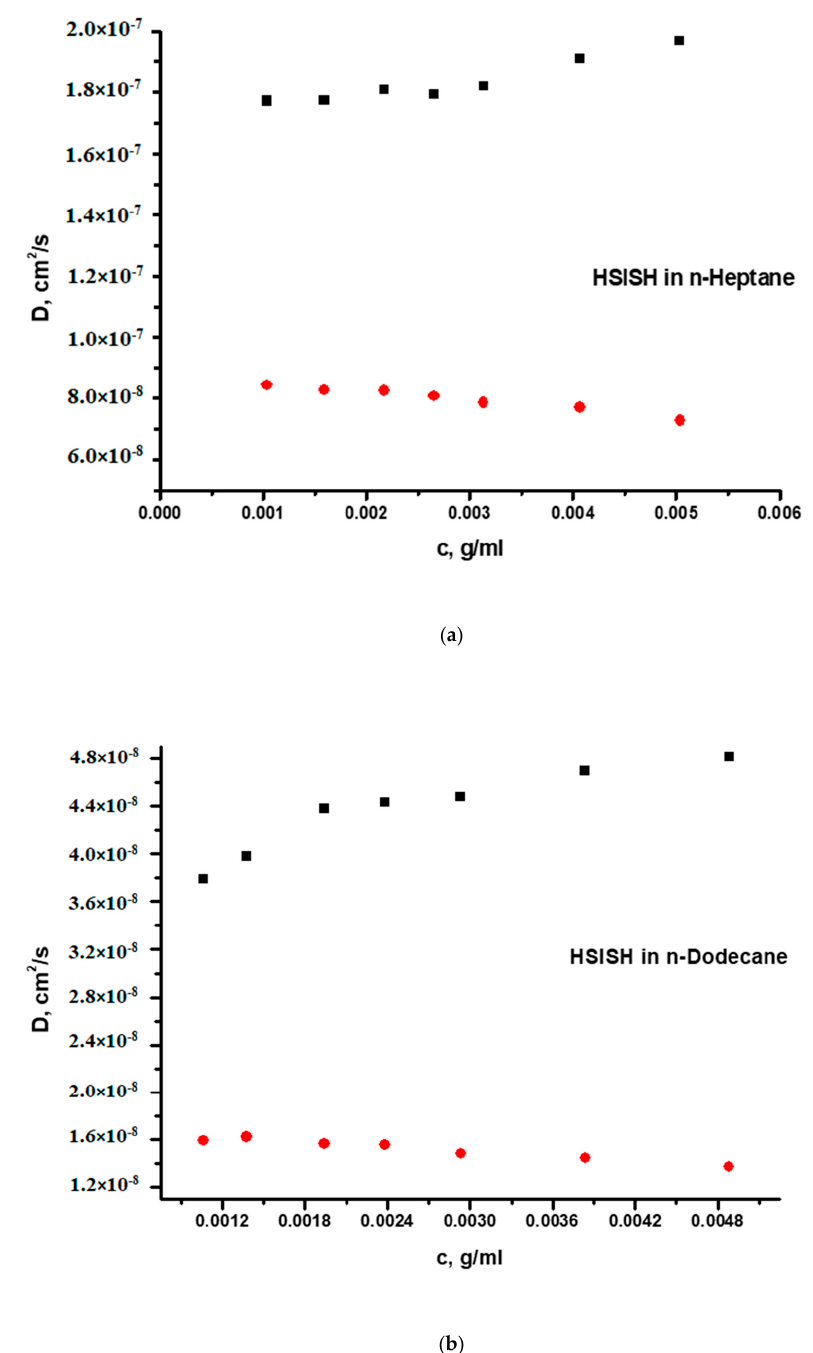
Commented [M2]: Please change the vertical axis to scientific counting.